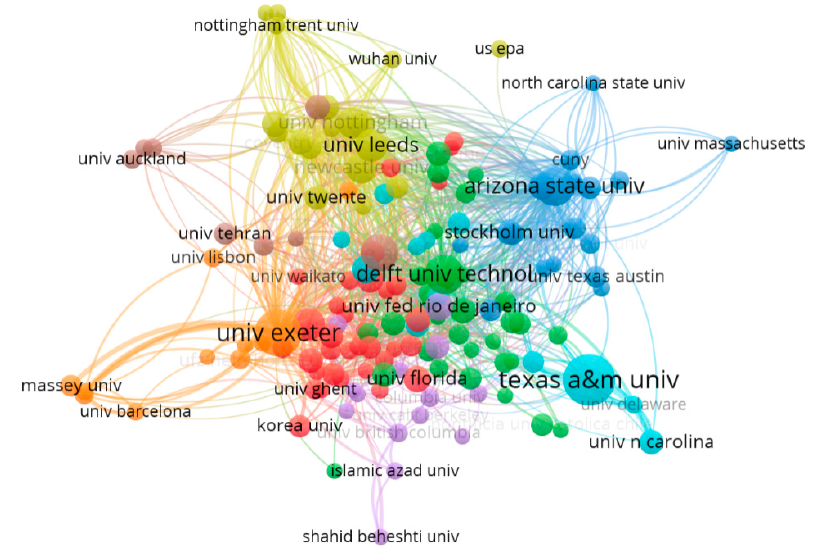
Figure 5. Network of structural relationships for the study of urban flood resilience 1999–2021. Table 1. Table of the top ten number of papers published by research organizations.